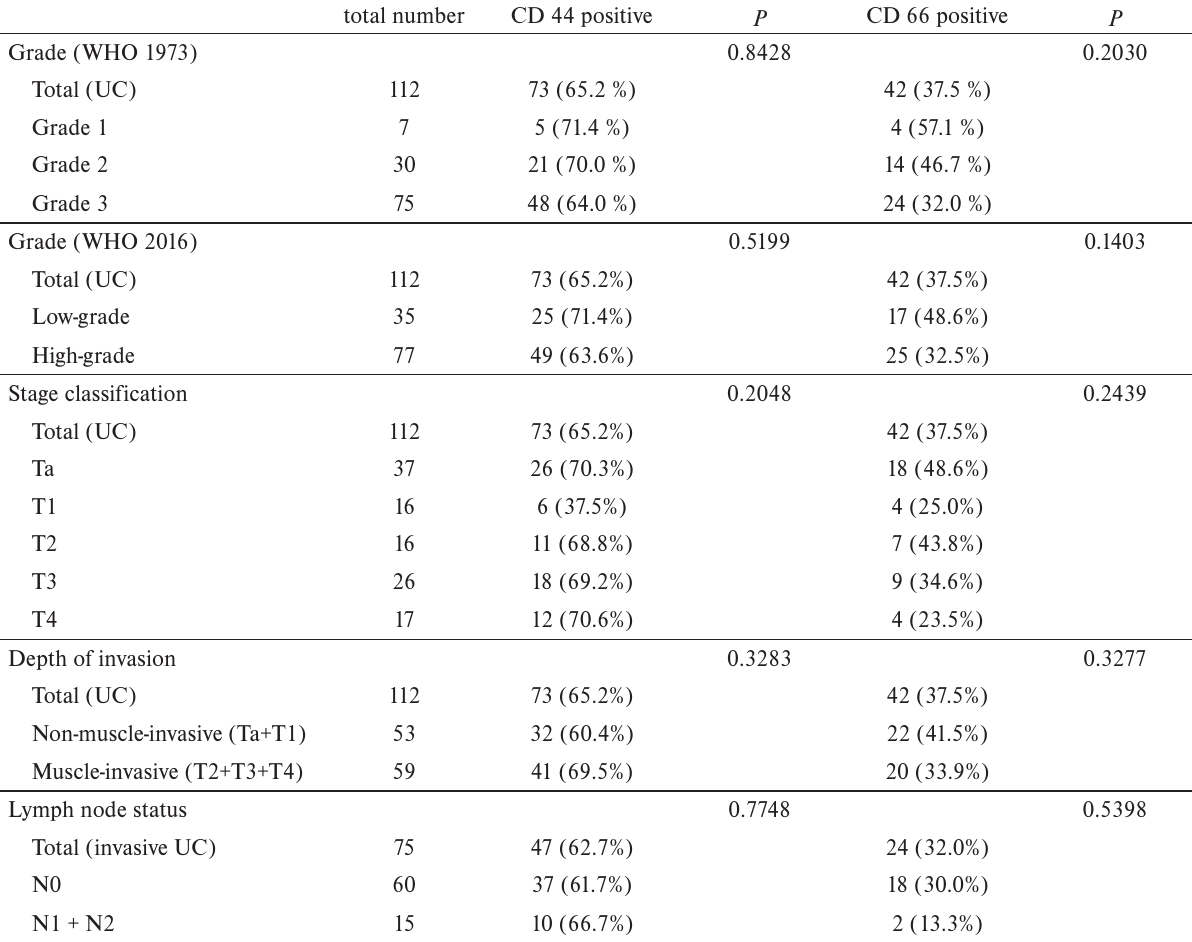
Table 3. Association of CD44 and CD66 expression with the histopathological characteristics of urinary bladder